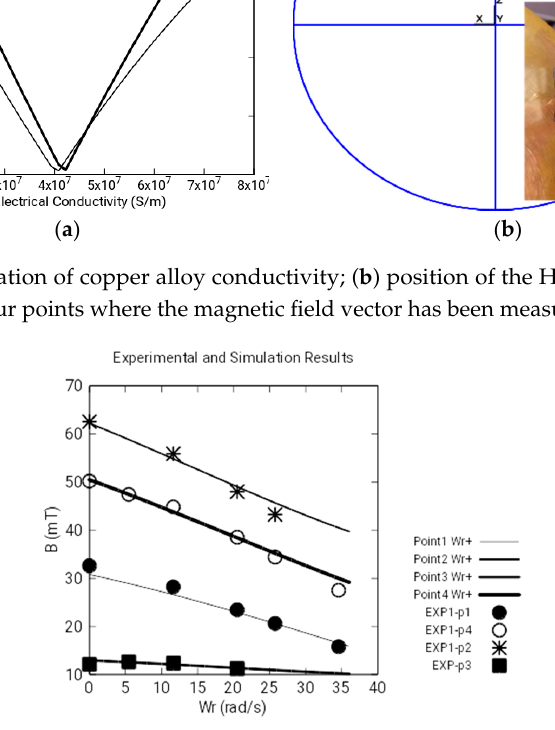
Figure 8. ( a ) Optimization of copper alloy conductivity; ( b ) position of the Hall sensors on the disk and position of the four points where the magnetic field vector has been measured.